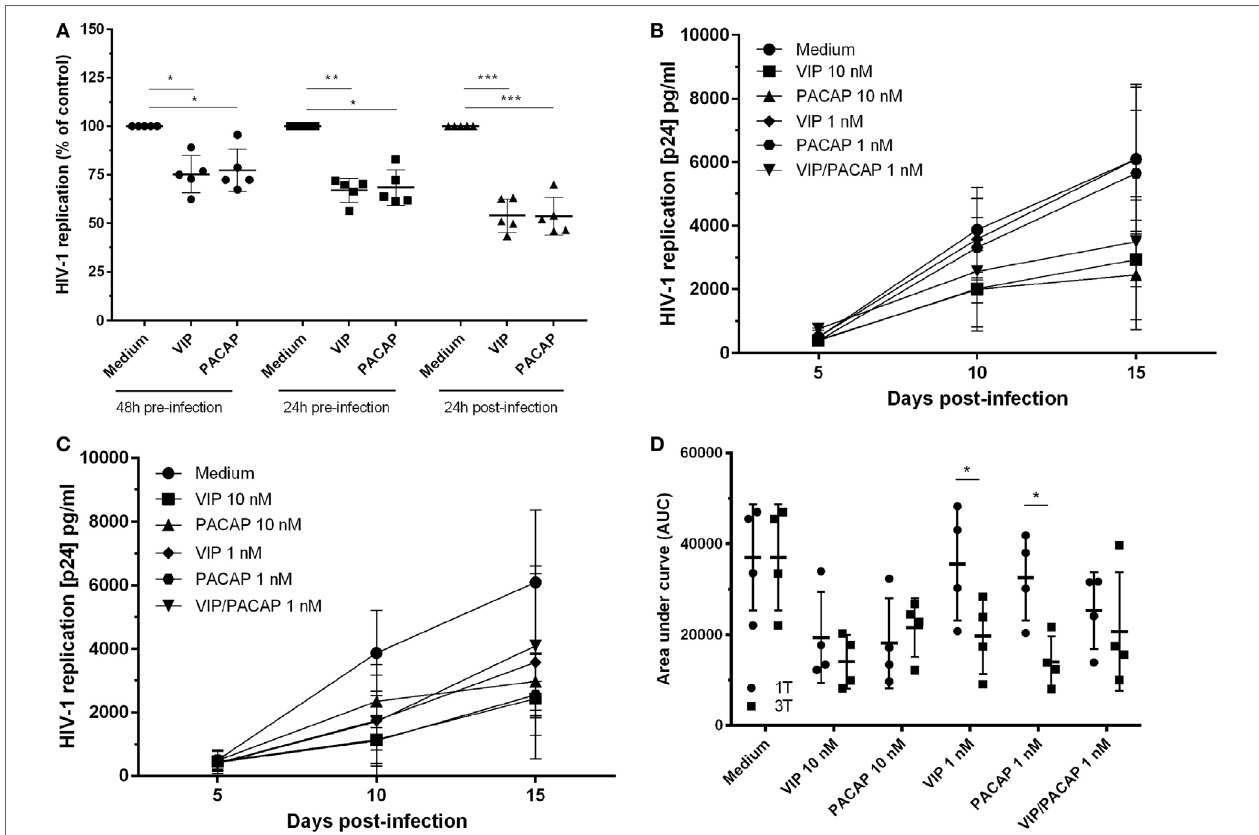
FigUre 1 | Vasoactive intestinal peptide (VIP) and pituitary adenylate cyclase-activating polypeptide (PACAP) retain the anti-HIV-1 effect at different modes of addition to macrophages. (a) Macrophages were treated with VIP or PACAP (10 nM) 24 or 48 h prior, or 24 h after infection. After 14 days of infection, supernatants were collected and viral replication was measured ( n = 5). Macrophages were infected and treated with different concentrations of VIP or PACAP in a regime of one dose at day 1 [ (B) , 1T] or three doses at day 1, 5, and 10 [ (c) , 3T]. Supernatants were collected 5, 10, and 15 days after infection. (D) Area under curve (AUC) analysis of panels (B,c) ( n = 4). * p < 0.05; ** p < 0.01; *** p < 0.001; two-way ANOVA, with Tukey